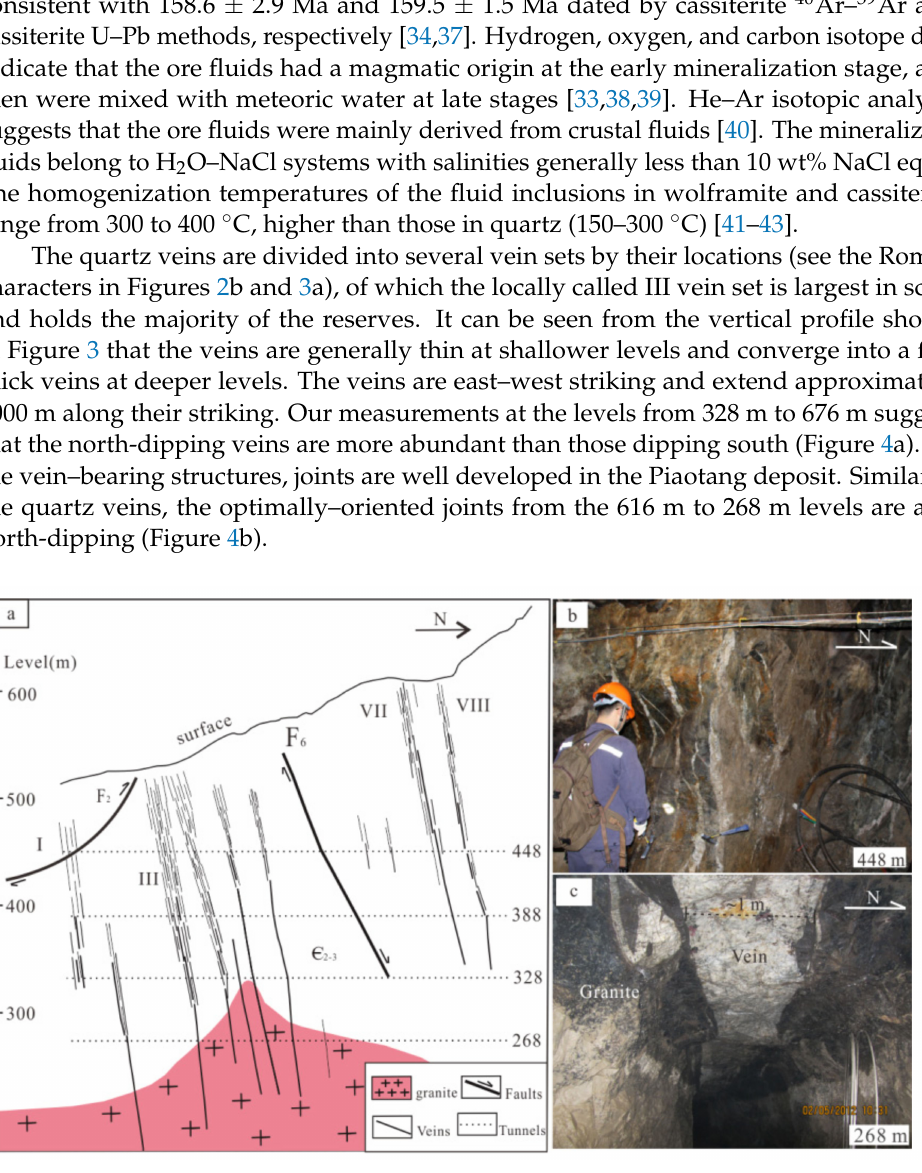
Figure 3. ( a ) A cross section of the Piaotang deposit along the 7th exploration line (revised from [31]). The dotted lines (e.g., 448 m) refer to the elevations of tunnels, and the Roman characters like III represent the vein sets. ( b , c ) are typical veins of the III vein set at the levels of 448 m and 268 m,